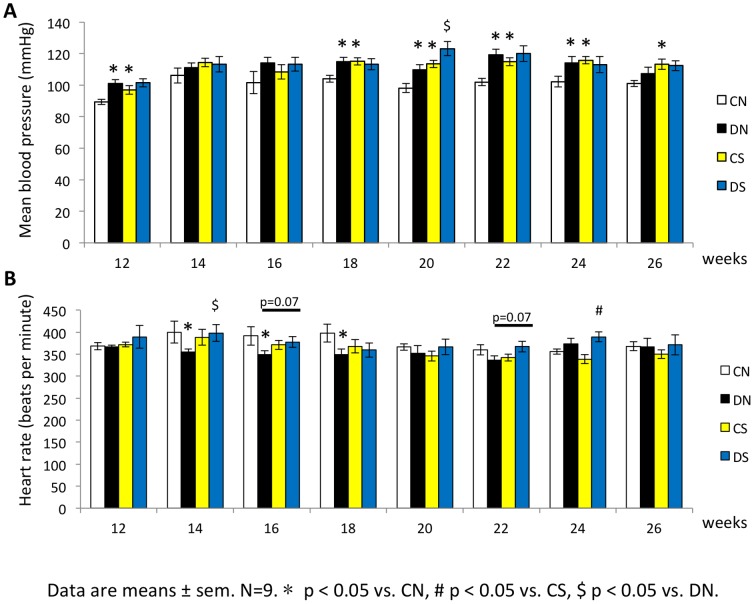
GDM rat model induced high blood pressure in male offspring.(A–B) Blood pressure and heart rate were determined in conscious rats from all offspring groups by an indirect tail-cuff method. Three stable consecutive measurements of blood pressure and heart rate were averaged. Data are means ± sem. N = 9. * p<0.05 vs. CN, # p<0.05 vs. CS, $ p<0.05 vs. DN.